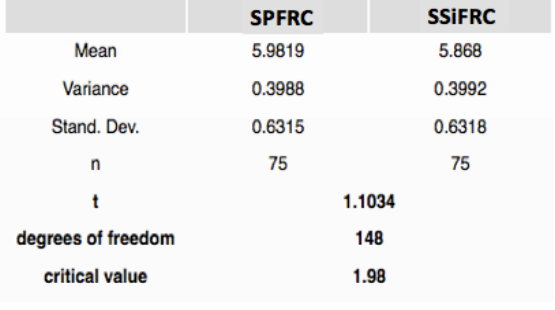
Figure 6. T-test